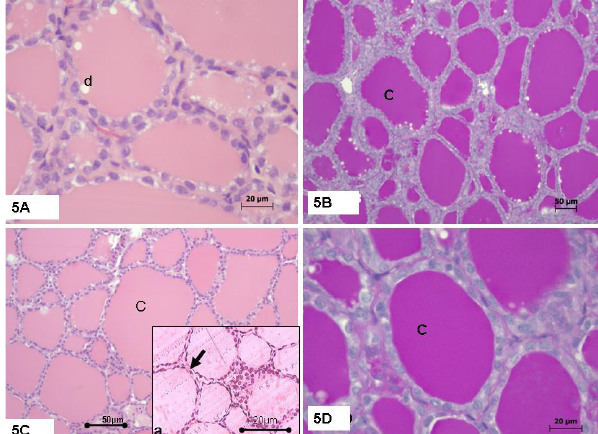
Fig. 5A. Photomicrograph of thyroid of goat of 1-2 years showing follicles of varied sizes distended with colloid and peripheral colloid droplets (d). H – E (bar scale 20 μm); Fig. 5B. PAS-stained sections of thyroid of 1-2 years showing strongly stained colloid (C) with peripheral vacuoles. PAS (scale bar 20 μm); Fig. 5C. Photomicrograph of thyroid of